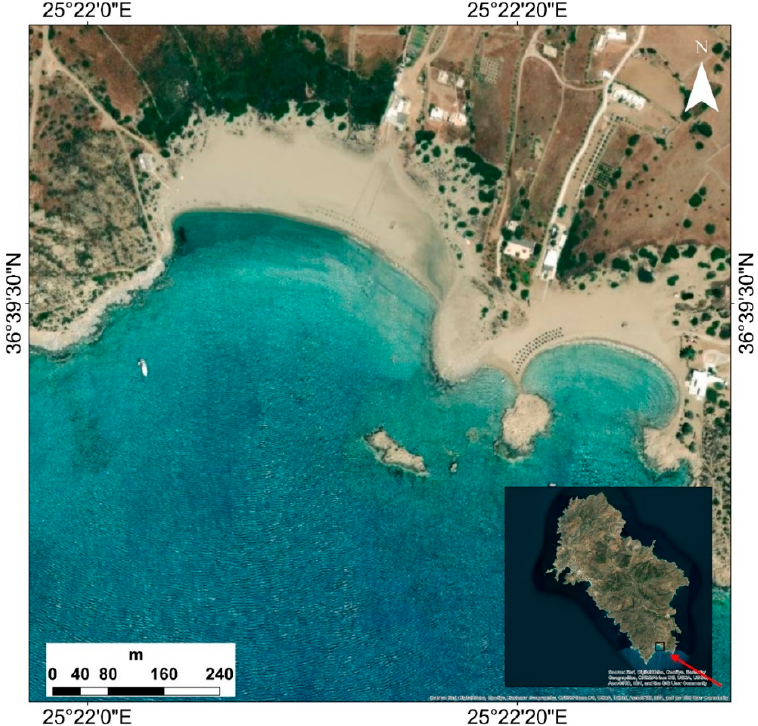
Figure 3. Magganari Beach is located at the southern part of Ios. Red arrow indicates the position of the study area.